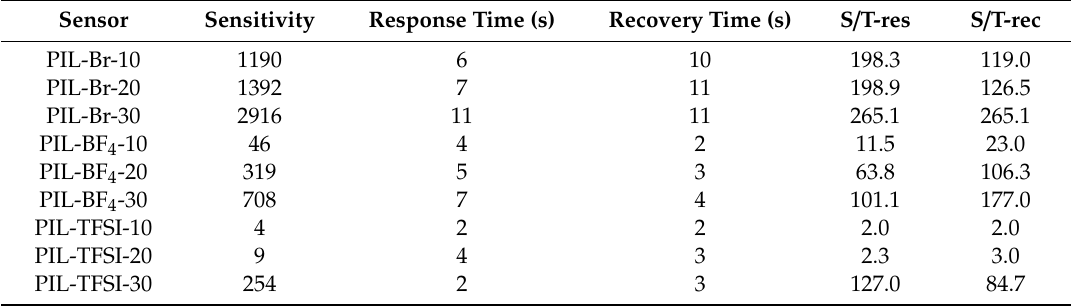
Table 1. The performance parameters of the as-prepared PIL-based humidity sensors.